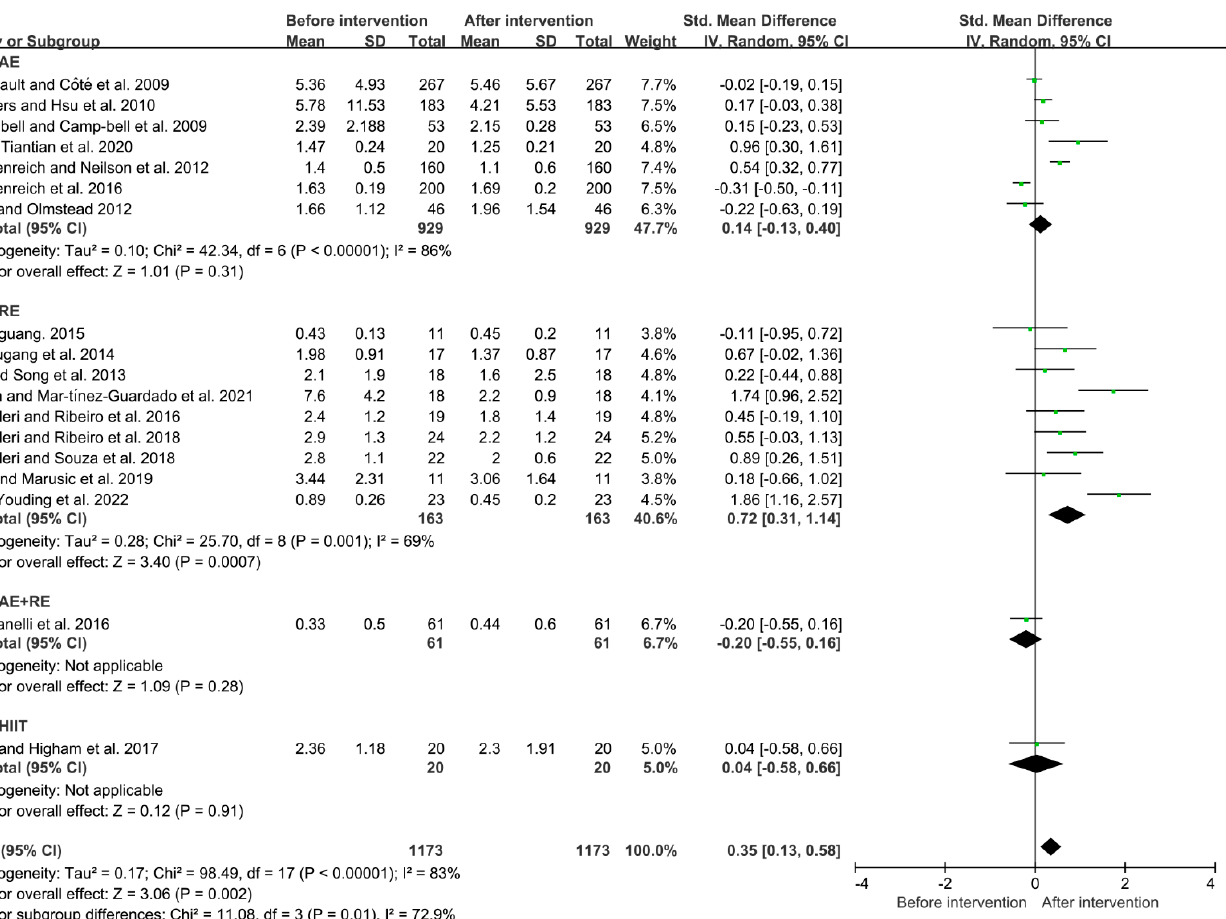
Figure 6. Effects of different exercise modes on CRP in the elderly [14–18,21,23,24,26,28–30,33,34,37,38,41,42].